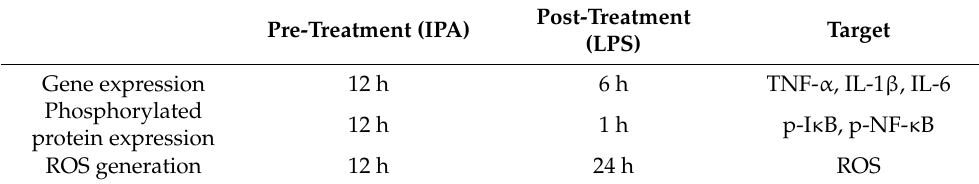
Table 1. Experimental settings of co-treatment IPA and LPS.